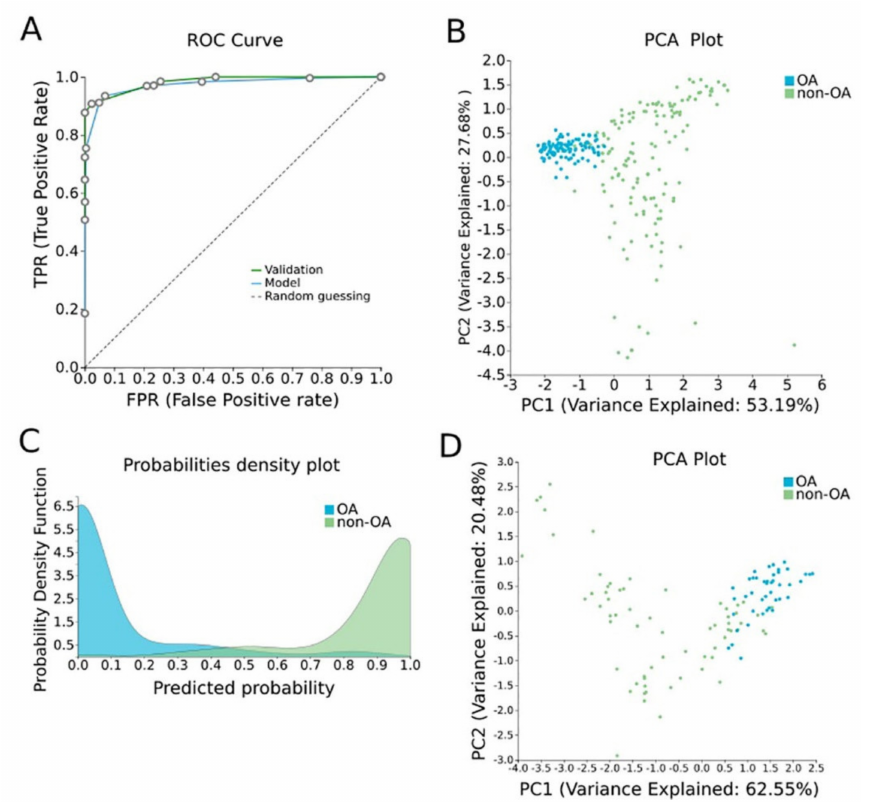
Figure 4. OA-specific methylation biosignature built using AutoML. ( A ) ROC curves of training (blue line) and validation (green line) models. ( B ) Supervised PCA plot (i.e., only considering the selected relevant biomarkers) presents separation between OA (blue) and non-OA healthy tissues (green) within the training group. ( C ) Out-of-sample probability density plot (i.e., probability predictions when samples were not used for training) depicts discrete distributions among studied classes of the training group. ( D ) PCA plot presents separation between OA (blue) and non-OA healthy tissues (green) within the validation group. Abbreviations: OA = osteoarthritis, ROC = receiver operating characteristic, PCA = principal component